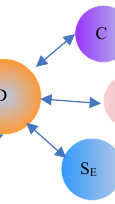
Figure 2. Heterogeneous drug information. PPI, protein-protein interaction.